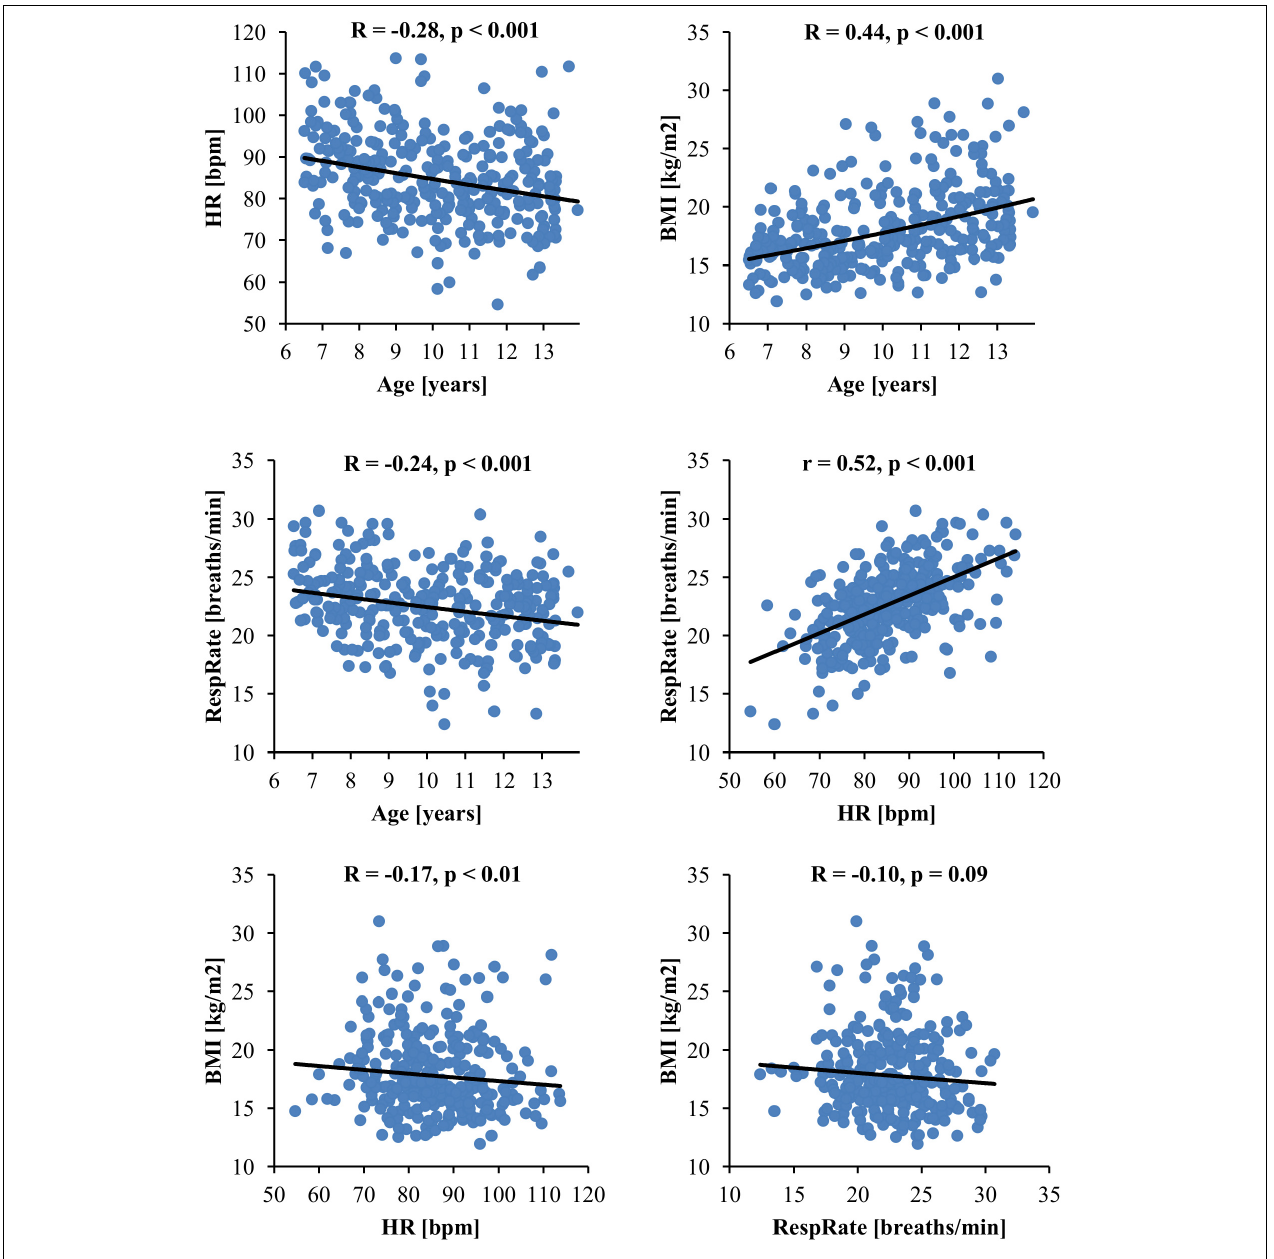
FIGURE 1 | Association between variables selected as potential independent predictors of standard HRV parameters. BMI, body mass index; HR, heart rate; HRV, heart rate variability; RespRate, respiratory rate; R, Spearman’s rank correlation coefficient; r, Pearson’s correlation